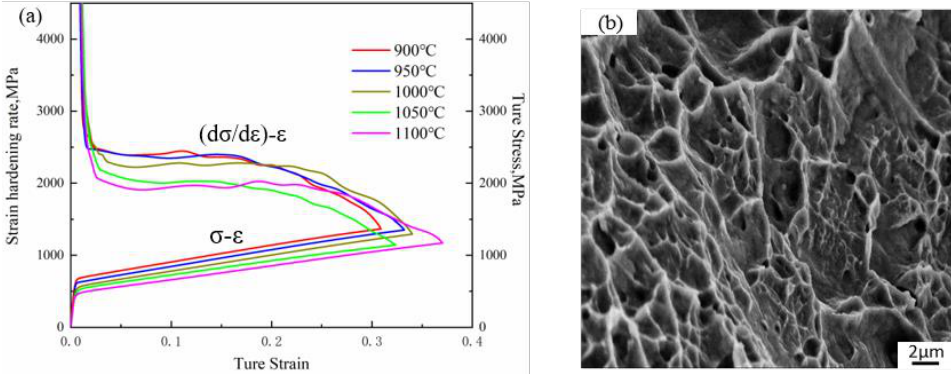
Figure 6. ( a ) True stress – strain curve and work hardening rate curve; ( b ) 950 °C fracture morphology.